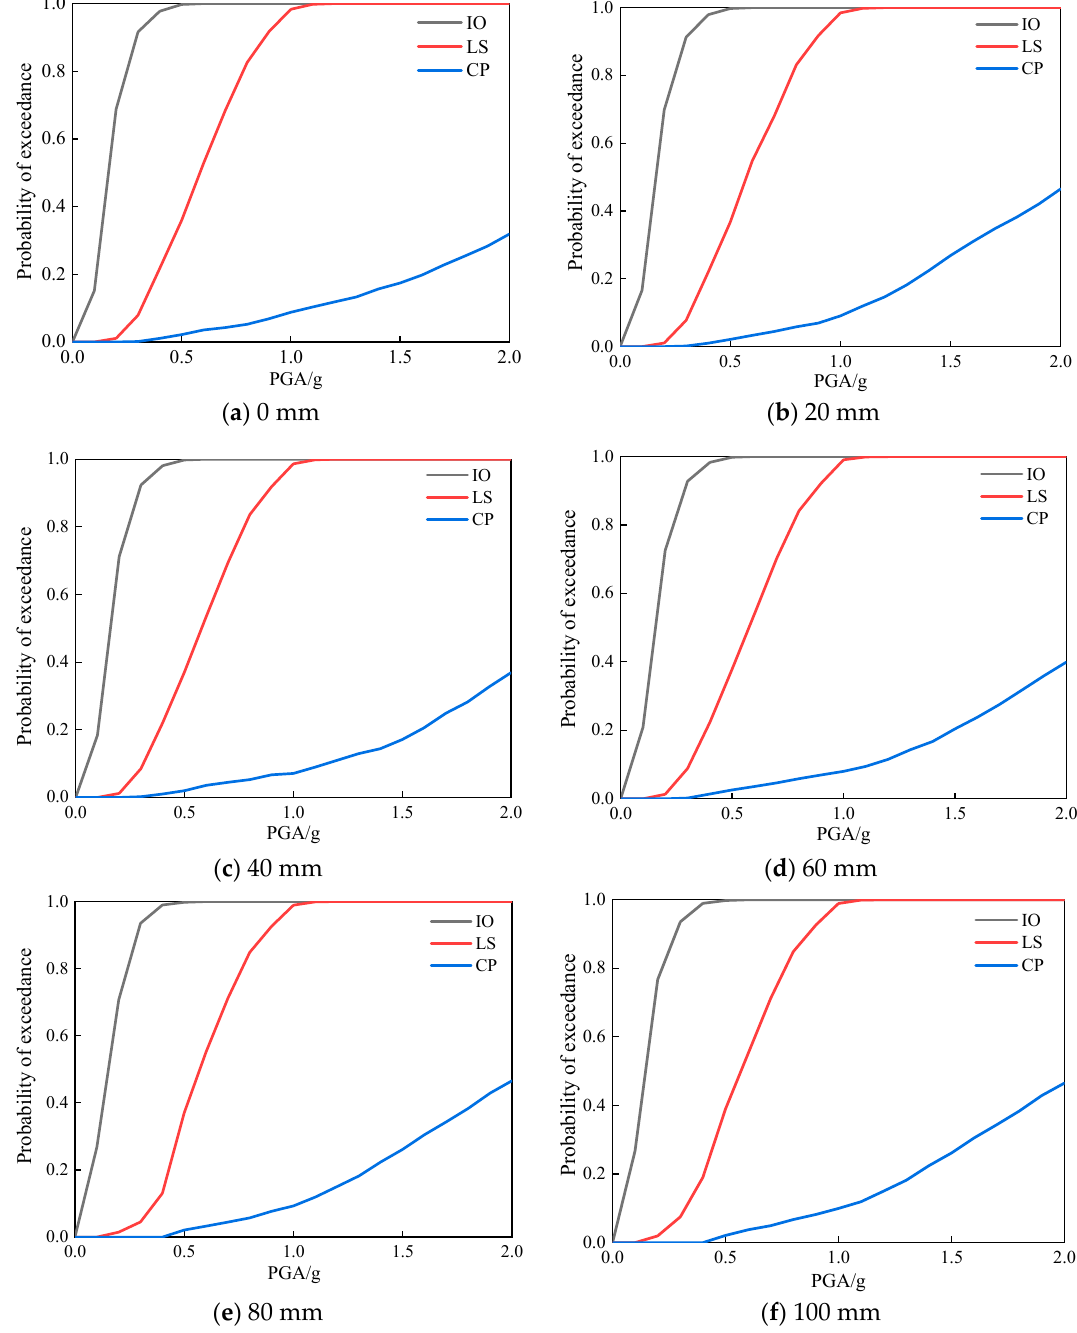
Figure 11. Fragility curves of structures with different uneven settlement quantities in Zone III.